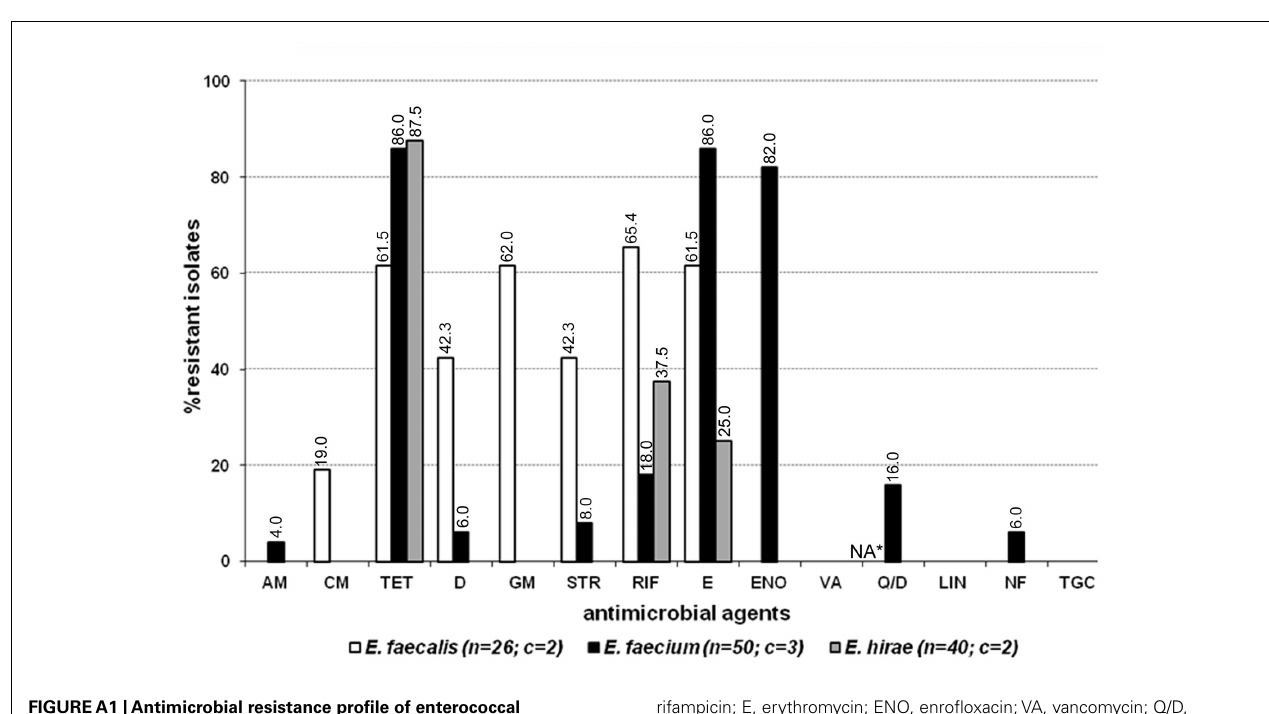
FIGUREA1 |Antimicrobial resistance profile of enterococcal isolates from the feces of four resident cats from small animal veterinary hospitals that had never been administered any antimicrobial agents. AM, ampicillin; CM, chloramphenicol;TET, tetracycline; D, doxycycline; GM, gentamicin; STR, streptomycin; RIF,